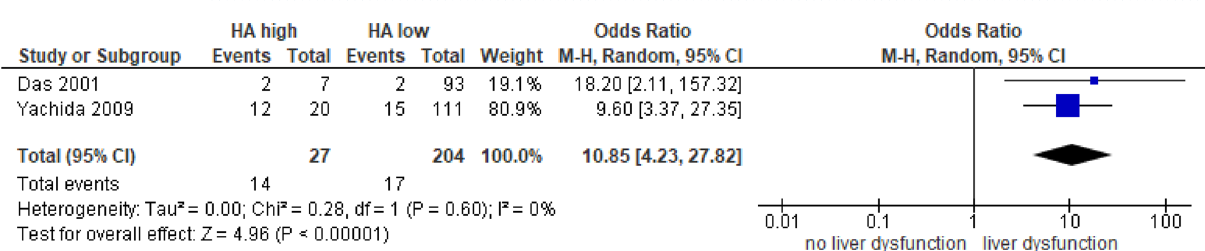
Figure 2. Forrest plot of studies examining IL-6 levels and organ failure.